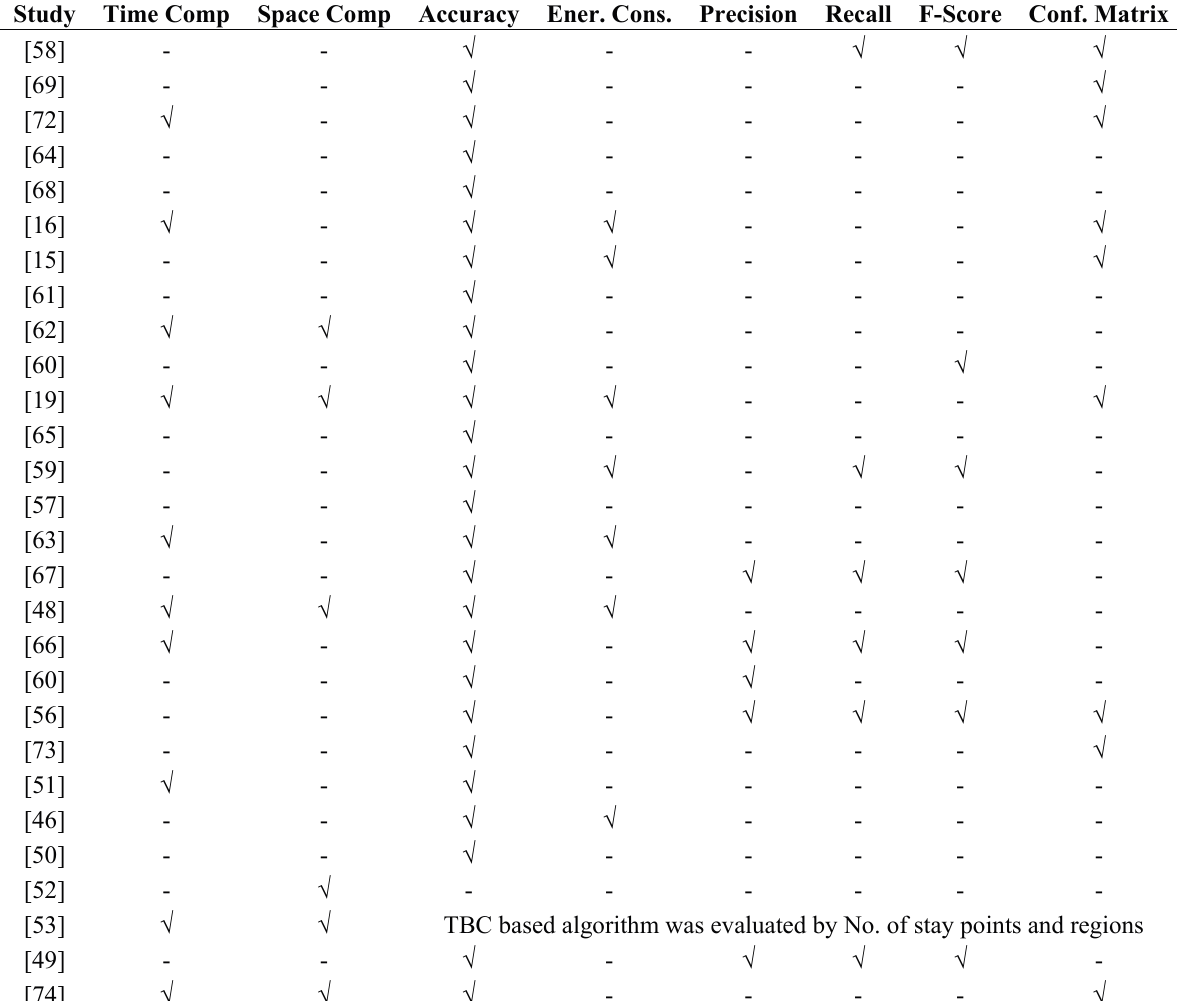
Table 6. Evaluation criteria for data mining algorithms in PSDs.